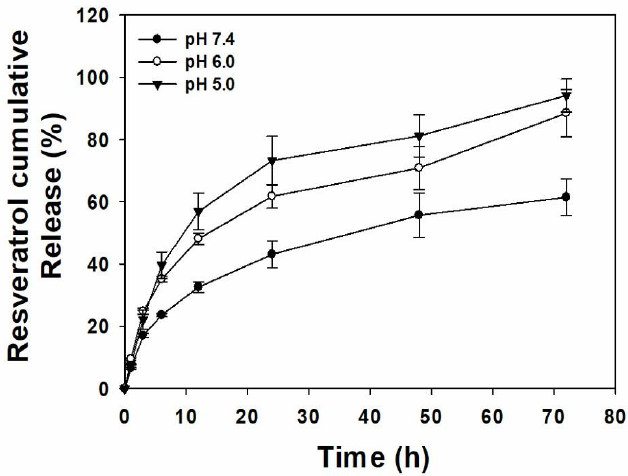
Figure 3. In vitro release behavior of RES from RES-UA NPs at pH 7.4, pH 6.0, and pH 5.0.